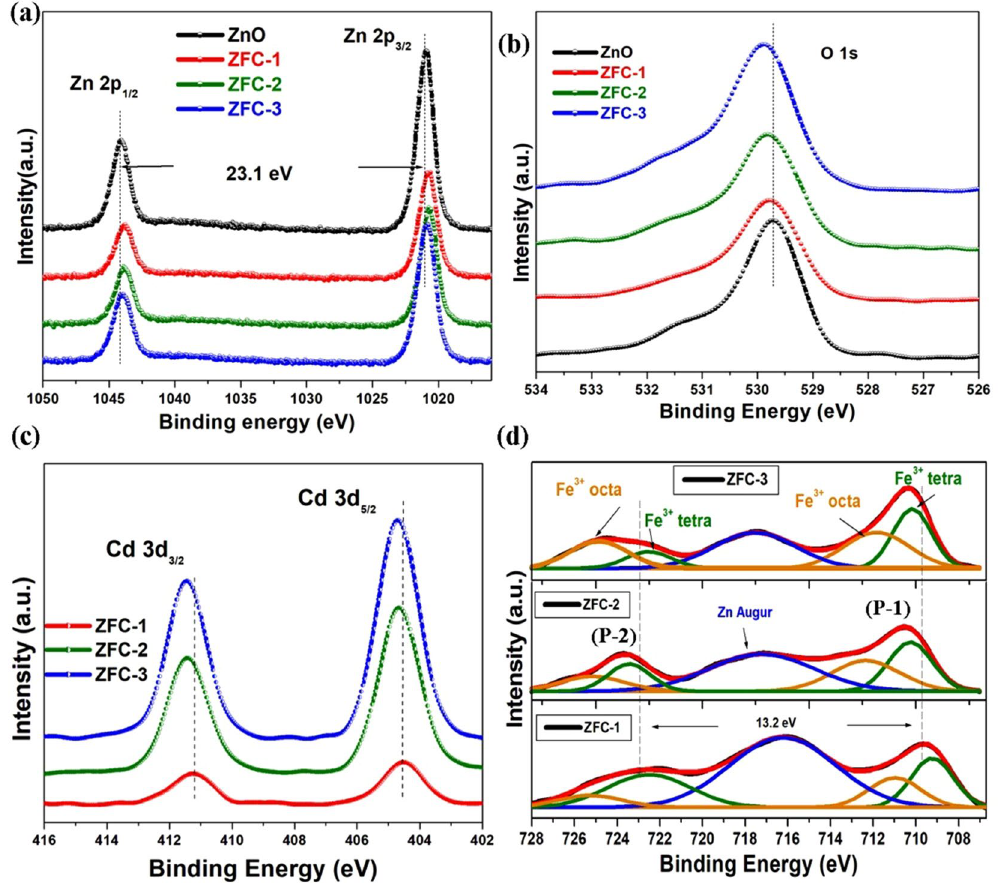
Figure 3. ( a ) HR Zn 2p core-electron region, ( b ) O 1s core-electron region, ( c ) Cd 3d core-electron region, and ( d ) Fe 2p core-electron region of all